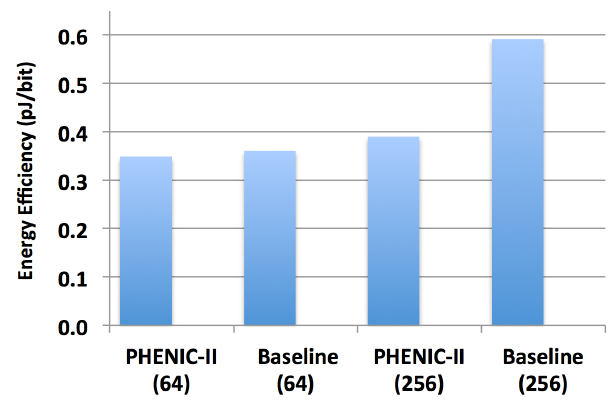
Figure 9. Energy efficiency comparison results under random traffic before the